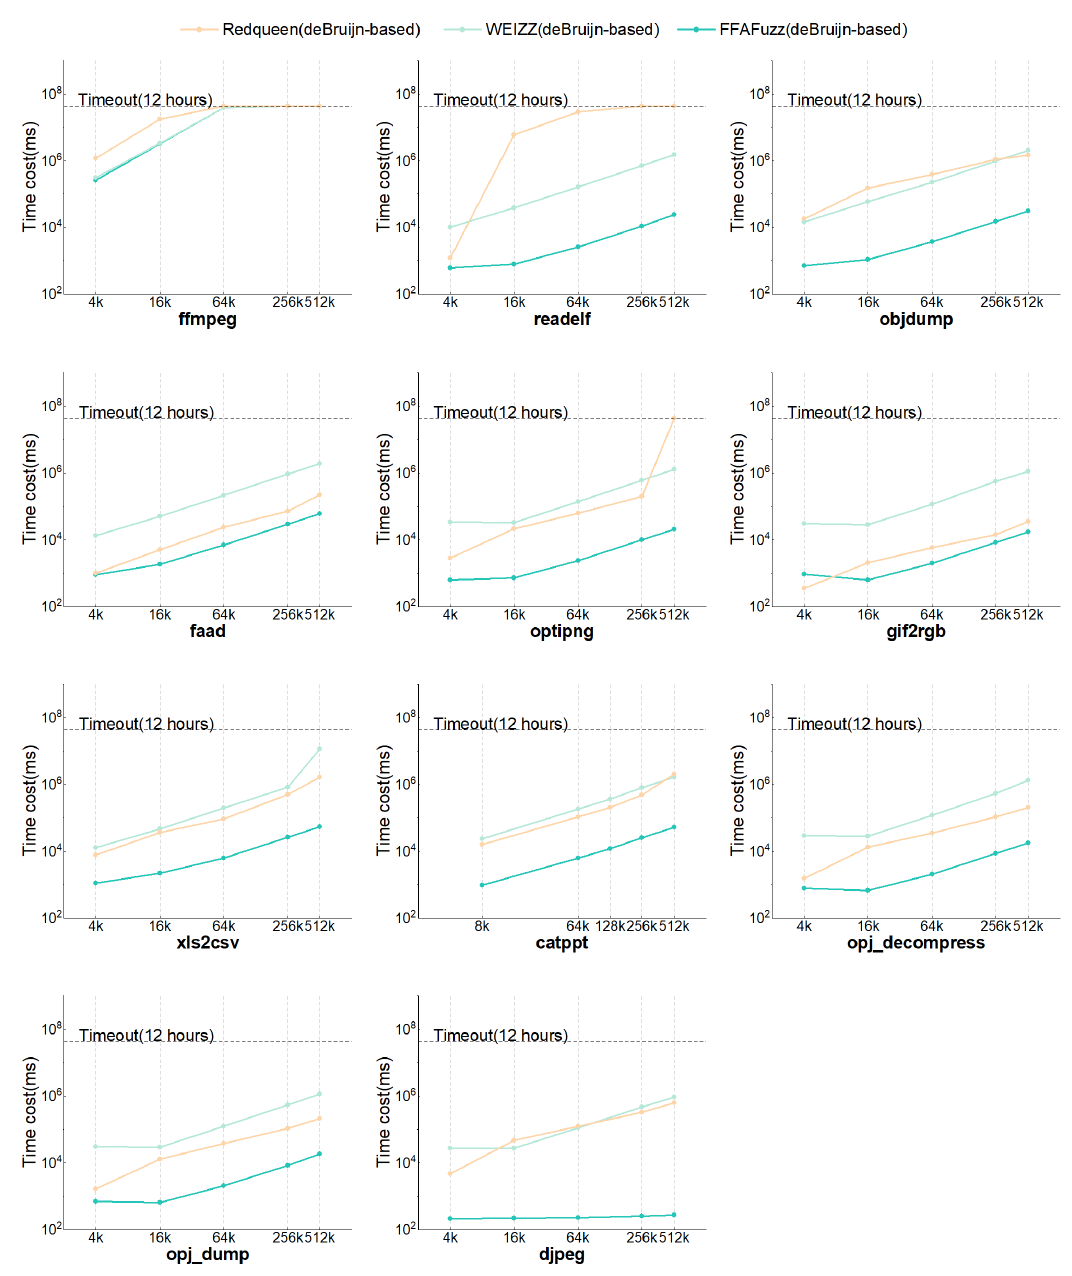
Figure A1. The time costs over the 11 targets of each compared fuzzer input with de Bruijn-based as the initial